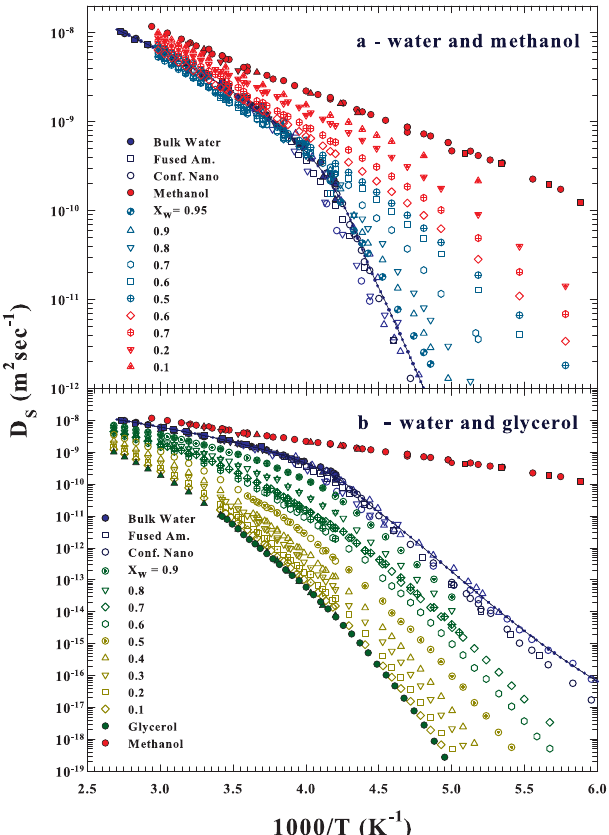
Figure 1. The self-diffusion, D S , of pure water, glycerol, and methanol and their water solutions (many are measured by using NMR and the other from the dielectric experiments DE ). The data are reported in one Arrhenius representation: log D S vs. 1000/ T . Many data have been measured just for this work (specifically for the water–methanol solutions ( a )) at X W = 0.95,0.9,0.8,0.7,0.6,0.5,0.4 for T < 278 K. In the water–glycerol case ( b ), the measured concentrations are X W = 0.9,0.8,0.7,0.6,0.5,0.4 for T < 290 K). All other data come from the literature: for the methanol solutions, References [48–55] and, for glycerol, References [48,57–61]. For water, the NMR data are proposed: (i) bulk water data (reported as fully blue symbols [62,63]); (ii) fused amorphous water (dark blue open squares [22]); (iii) MCM confined (actual data are proposed as dark blue squares and previous as blue triangles [32]; and (iv) finally, the dielectric relaxation data [64] (illustrated as blue open circles). Full and empty symbols represent pure materials and solutions,